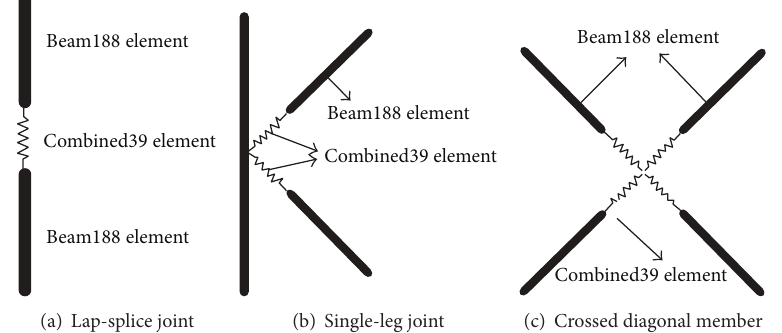
Figure 4: Joint slippage